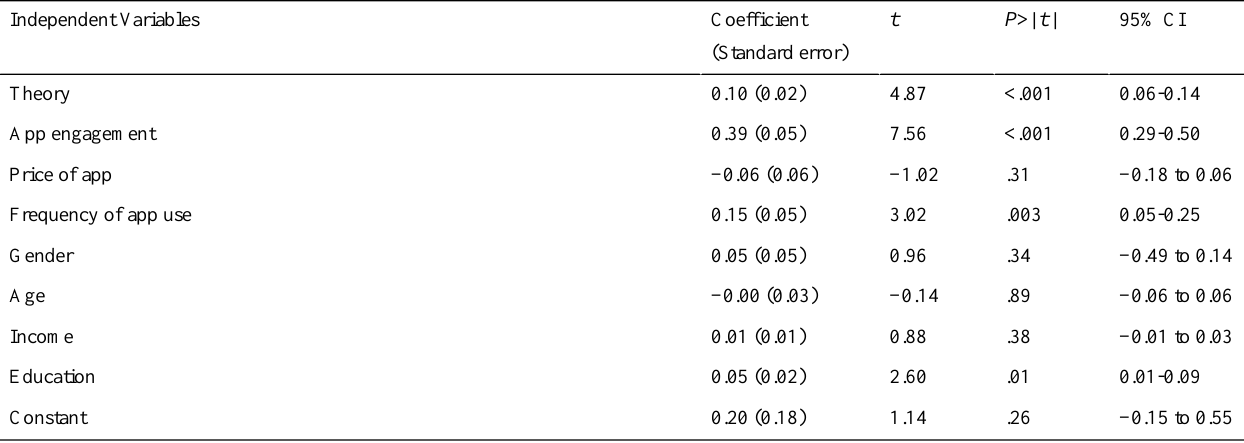
Table 6. Ordinary least squares regression results for determinants of behavior change.